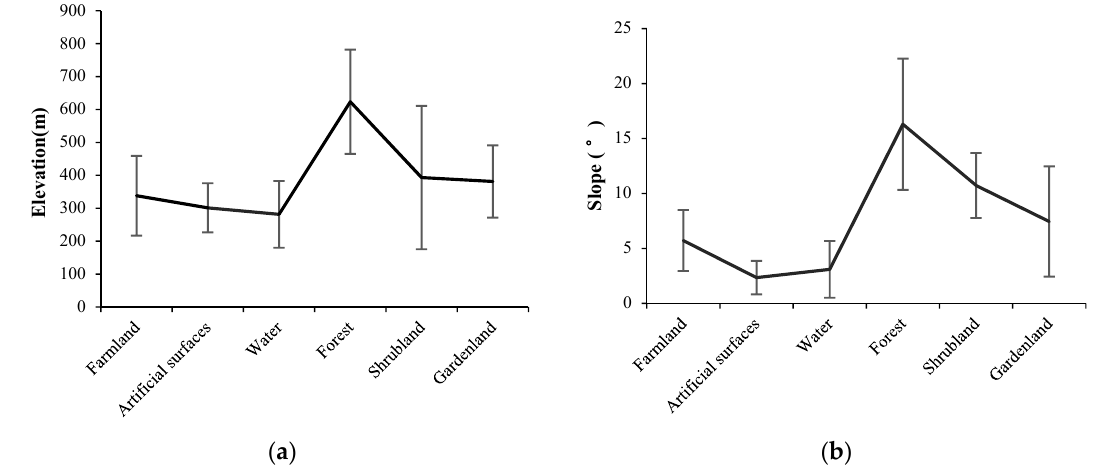
Figure 7. Elevation and slope of various land-cover types. ( a ) Elevation; (b) Slope.